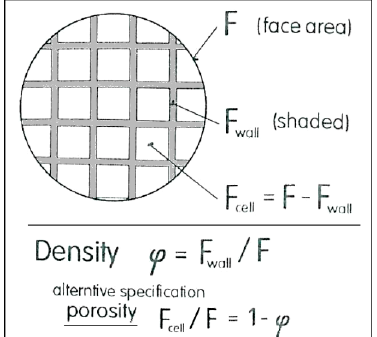
Figure 3. Definition of the area density characterizing the availability of free flow area of passages. It is a factor in experimental investigation that was typically performed with parallel flow over a determined face area F of the matrix.